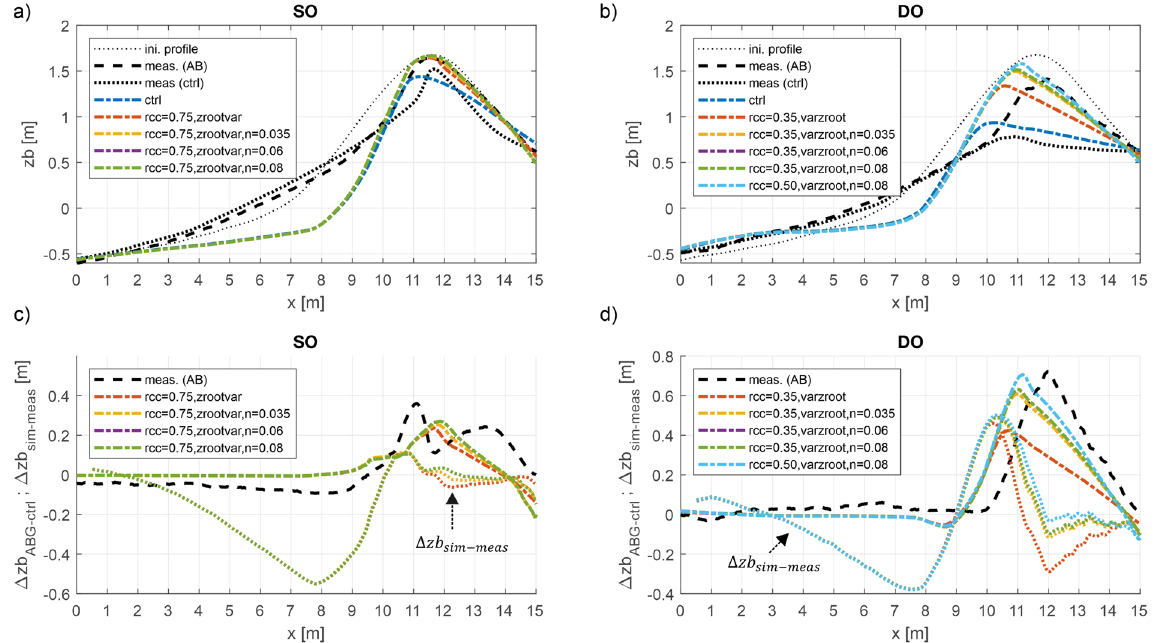
Figure 9. Modeling overwash conditions with aboveground and belowground biomass: Comparison of initial (thin dotted), final measured control (thick dotted, black) and final measured ABGB (dashed, black) dune profiles with simulation results (dash-dotted, black) for shallow-overwash ( a ) and deep-overwash ( b ). The root model was applied with a varying rooting depth ( varzroot ) and combined with locally increased friction coefficients. Further shown are the profile differences between belowground and the control for the measurements (dashed) and the simulations (dash-dotted), and the difference between simulations and measurements (dotted) for shallow- ( c ) and deep-collisions ( d ). Note : Overlay of the green and purple lines. Table 7. Percentage decreases in overwash compared to the control cases for shallow-overwash and deep-overwash conditions. The root model was applied with various rooting depths with rcc = 0.75 for SO and rcc = 0.35 for DO.